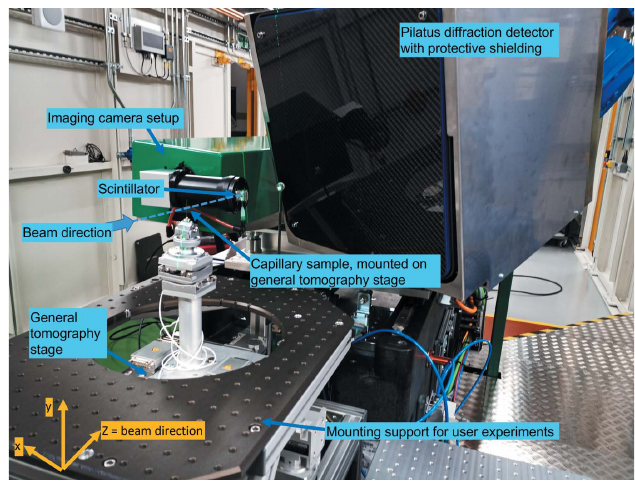
Figure 1 DIAD endstation with capillary sample mounted on the general tomography stage, the imaging camera setup and the Pilatus diffraction